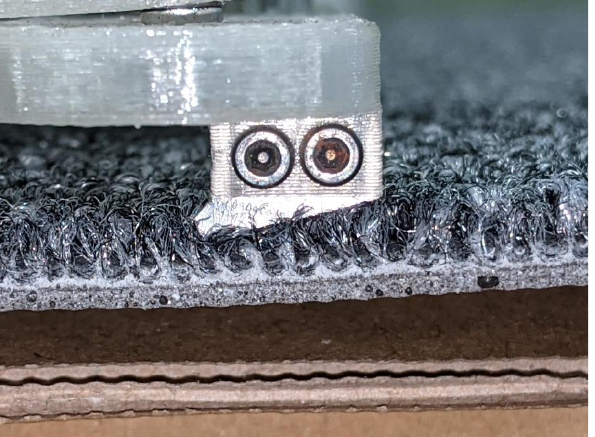
Figure 16. Photograph of the ground contact between the leg mechanism and the carpet surface. The right-hand direction is the direction of travel. The claw does not get caught in the direction of travel, so the leg can slide. In other words, the robot moves forward. In the opposite direction, the legs cannot slide because the claws get caught. In other words, it does not move